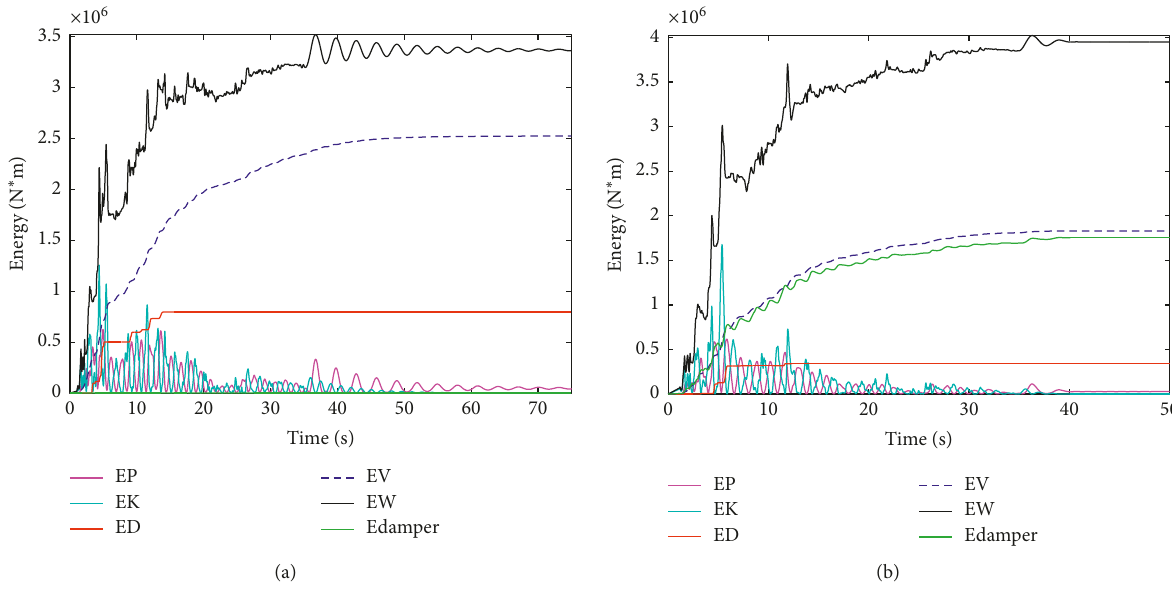
Figure 19: Energy-time history curves of the structure under the action of the 0.51g El Centro wave (EP denotes the structural potential energy, EK denotes the structural kinetic energy, ED denotes the structural plastic damage-associated energy dissipation, EV denotes the damping energy dissipation, EW denotes the earthquake input energy, and EDamper denotes the Reid damper energy dissipation): (a) uncontrolled structure; (b) controlled structure ( η 0 . (cid:31)